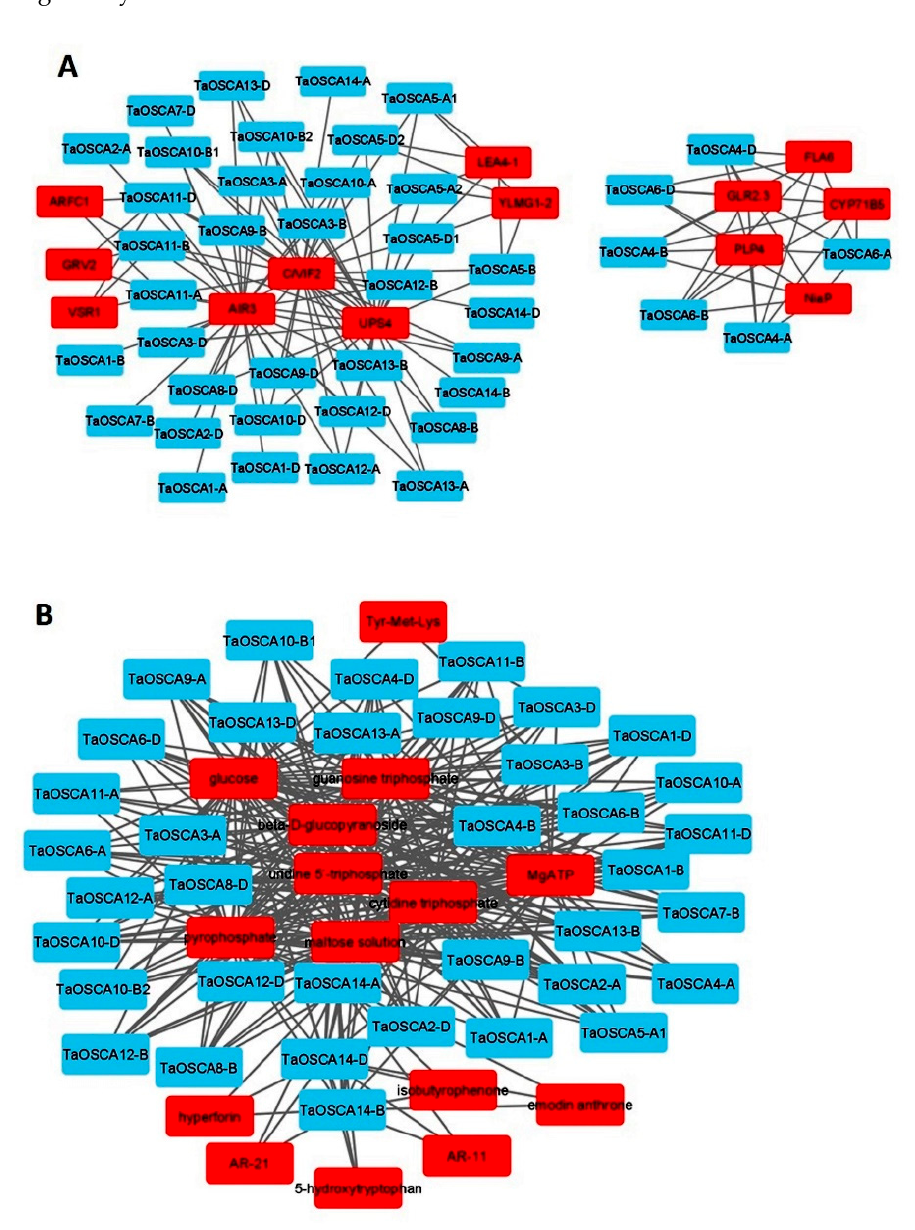
Figure 7. Interaction analysis of OSCA proteins using the STRING and STITCH servers. The networks ( A ) show the protein–protein interactions, where TaOSCA proteins are marked with blue and predicted interacting proteins are marked with red. The network ( B ) shows the protein–chemical interactions, where TaOSCA proteins are marked with blue and predicted interacting chemicals are marked with red. The networks were developed using the Cytoscape software.